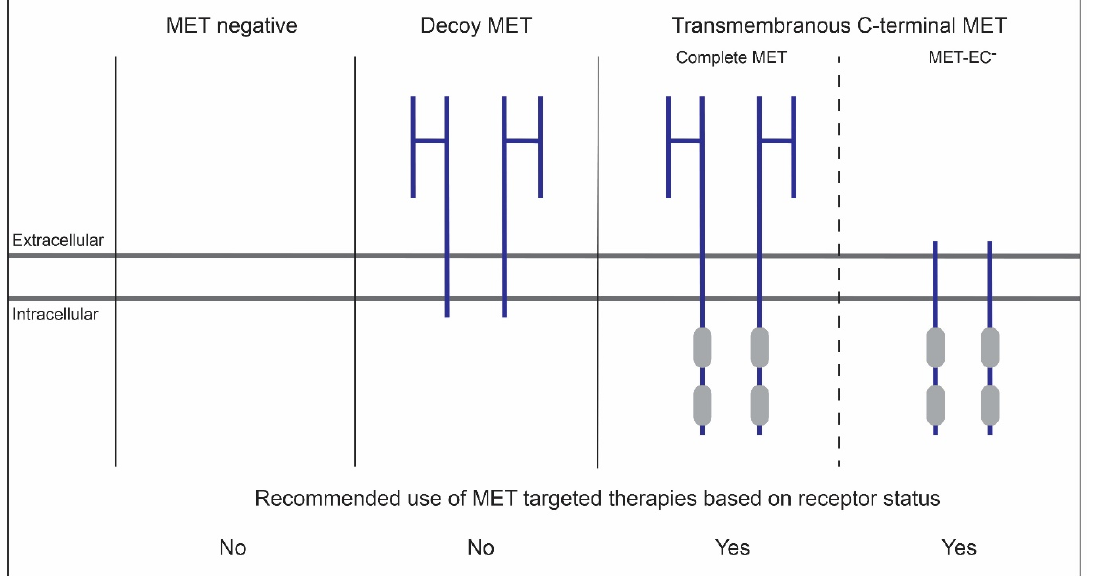
Figure 3. Recommended use of MET-targeted therapies, moAbs and/or TKIs, in OSCC based on the receptor’s post-translational status on the membrane. Use of MET moAbs directed against the N- term extracellular and C-terminal intracellular domain stratifies OSCCs into three categories: MET negative (no MET immunoreactivity), decoy MET (more positivity for the N-terminal moAb), and transmembranous C-terminal MET (equal positivity for both moAbs (complete MET) or more pos- itivity for the C-terminal moAb (complete MET and/or MET-EC - ). As patients falling in the third category develop cancers that are positive for the protein’s catalytic domain, they are presumably eligible for treatment with MET-targeted therapies. The use of MET moAbs or TKIs is recommended in case of complete MET. The use of TKIs, or a combination of TKI and moAbs, is recommended in case of complete MET and/or MET-EC - . This figure and its legend was inspired by Figure 10 and its legend by De Herdt et al.